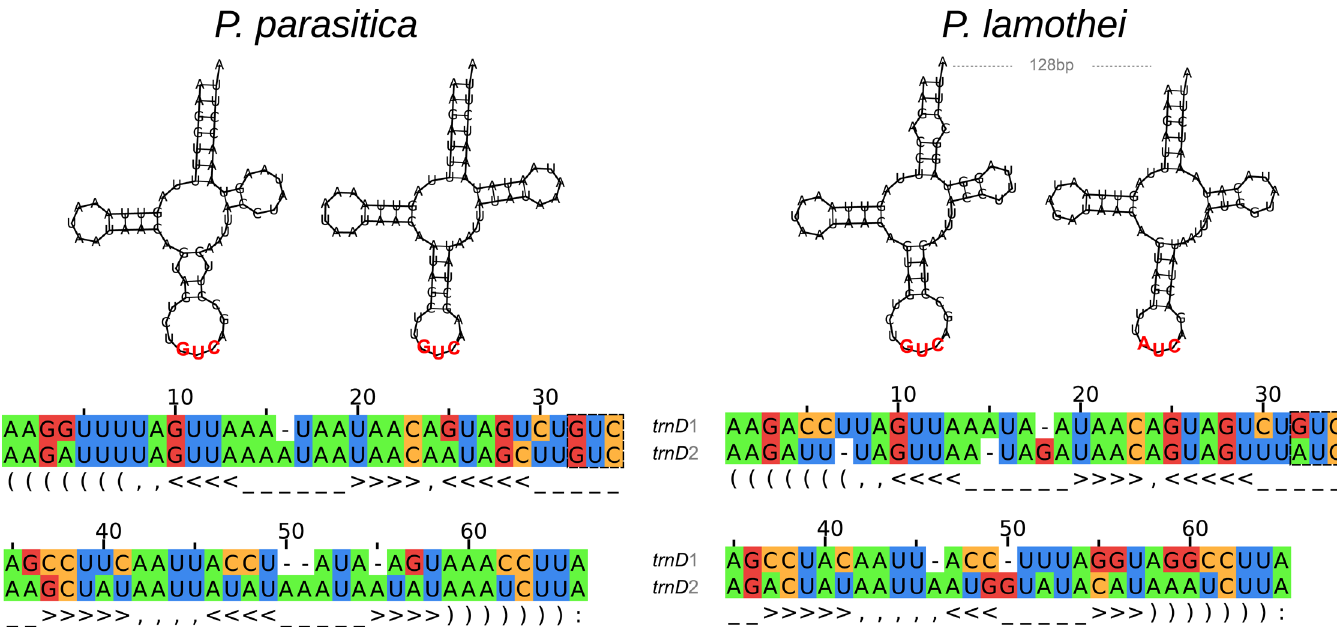
Fig 2. trnD duplication in Placobdella . Top: Secondary structures of Placobdella trnD genes as calculated by MITOS. Bottom: trnD sequences aligned against the 'Metazoa_D' model from MiTFi v0.1 [77] using cmalign from Infernal v1.1rc4 [78]; sequence alignments took into account the secondary structure of the trnD genes. Note that gaps in the alignment occur in the loop structures or the trnD ’ s.